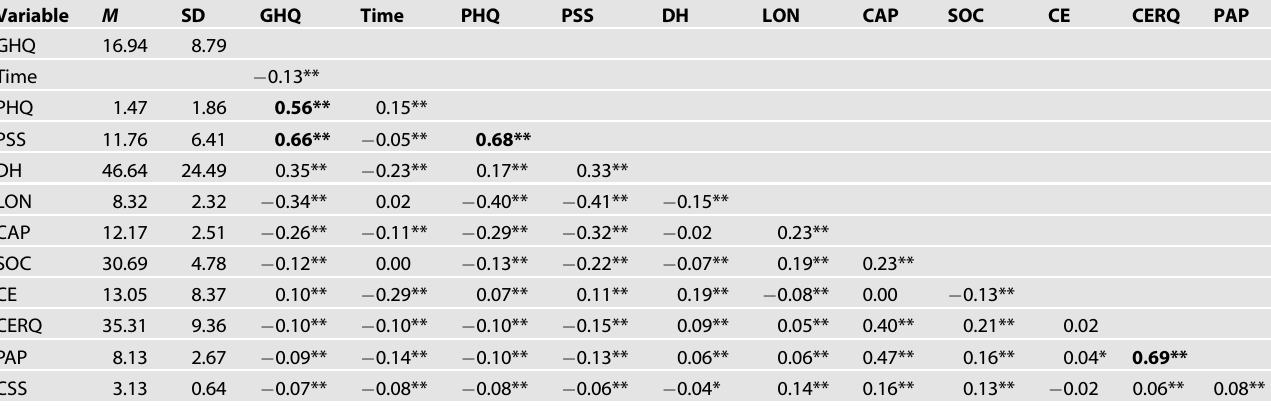
Table 1. Means, standard deviations, and correlations of the predictor variables with the dependent variable (GHQ-28).